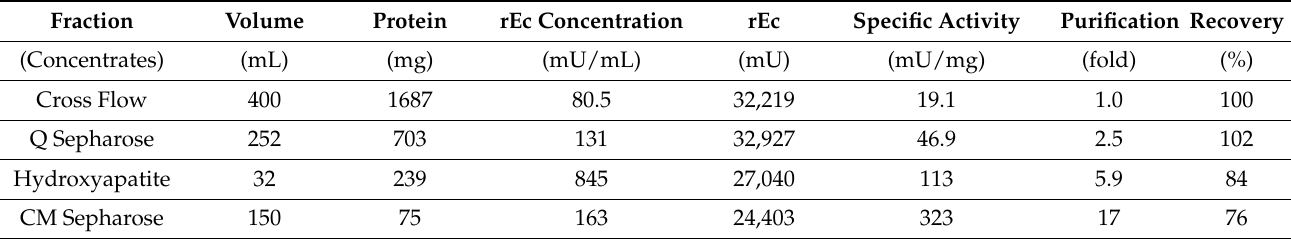
Table 1. Chromatographic Purification of